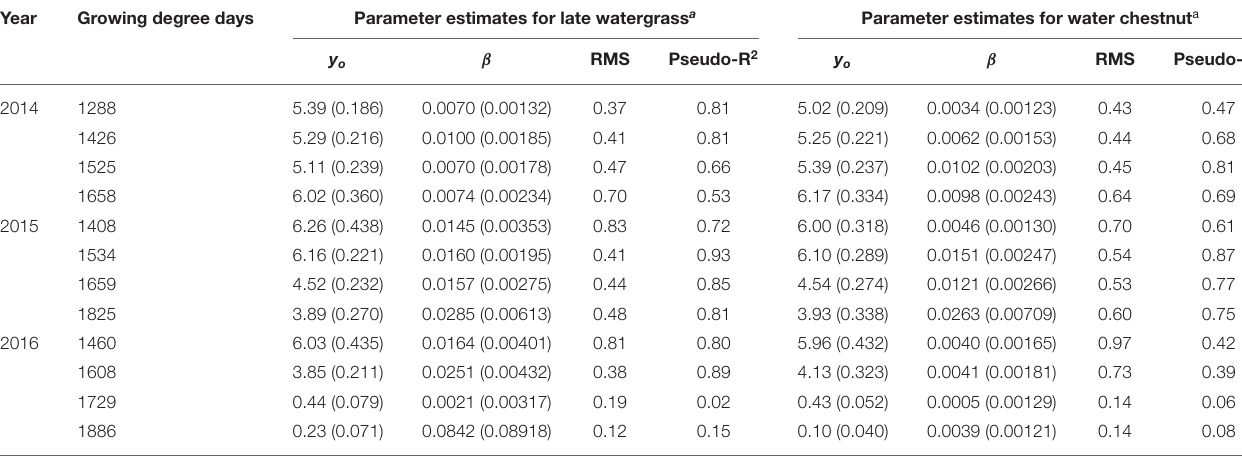
TABLE 2 | Parameter estimates for the rectangular hyperbolic model of rice grain yield as a result of single-weed interference caused by late watergrass and water chestnut at accumulated growing degree days (from transplanting to flowering, 89 days) in 2014, 2015, and 2016. Year Growing degree days Parameter estimates for late watergrass a Parameter estimates for water chestnut a